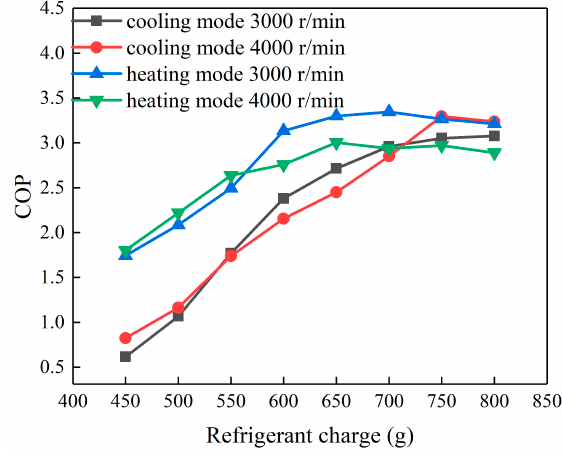
Figure 9. COP variations with refrigerant charge .